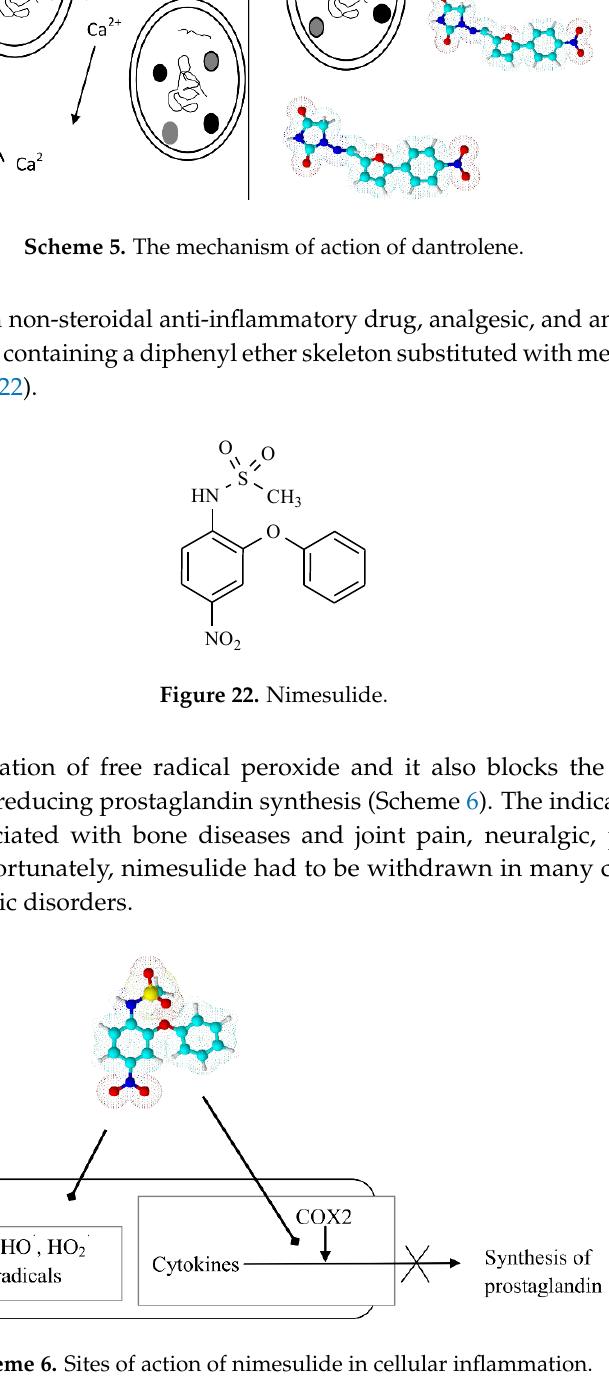
Figure 21. Dantrolene.